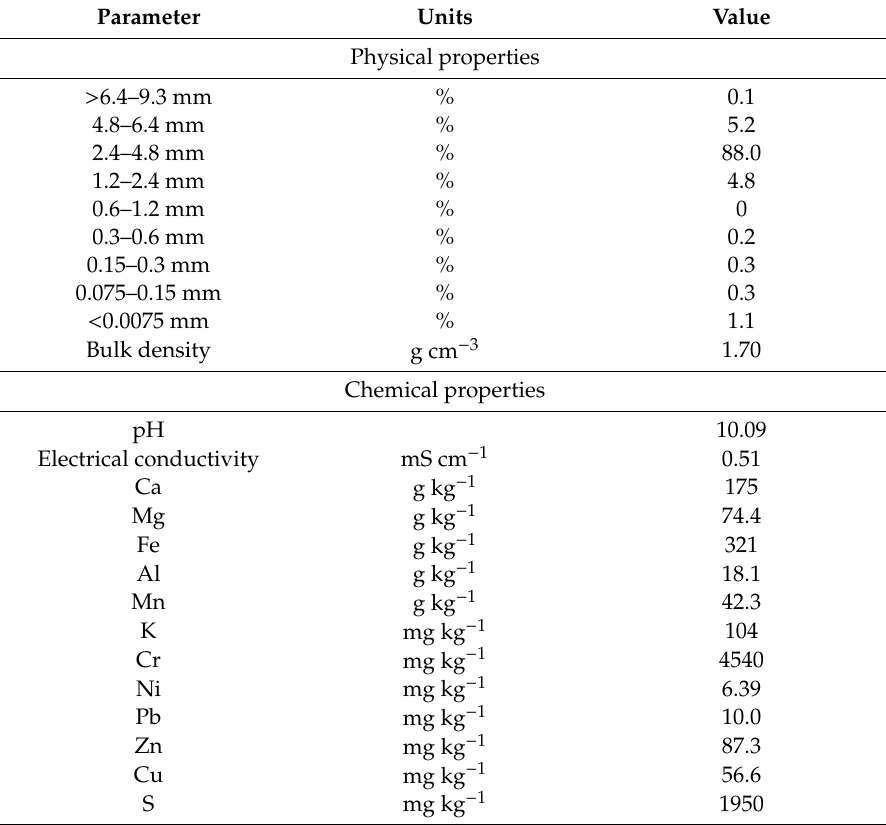
Table 3. Physical and chemical properties of the slag used in the blind inlet and laboratory flow-through experiments. Concentrations of elements are total